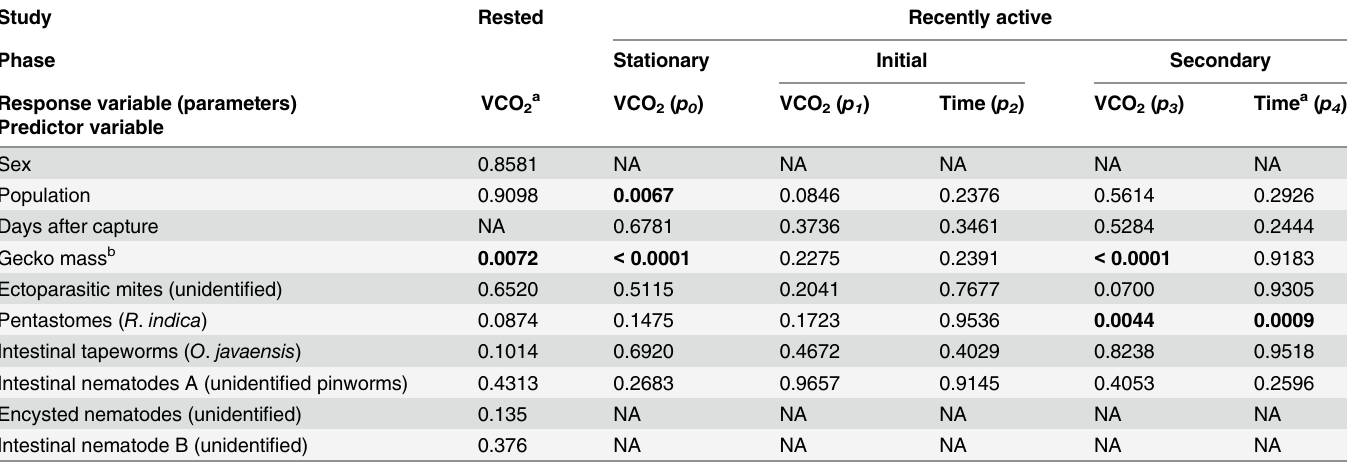
Table 1. Effects of explanatory variables on VCO 2 from rested geckos ( n = 48) and recently active geckos ( n = 70) analyzed by linear models. The same explanatory variables were used to assess time to recovery in recently active geckos. The P - values associated with significant predictors are in bold. F-values for these tests are reported in Table B in S2 File.